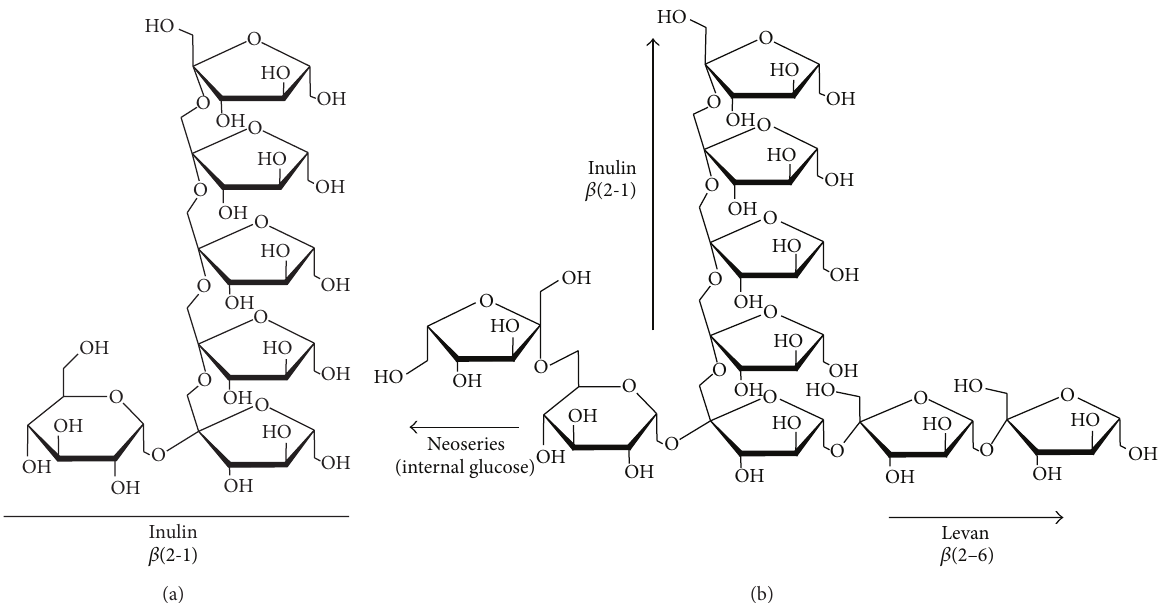
Figure 1: Structural comparison of the (a) inulin from Cichorium intybus and (b) agavin from Agave